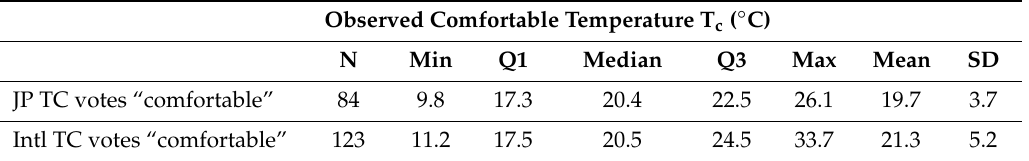
Table 10. Descriptive statistics of the actual temperature at TC + 1, + 2 and + 3 (Comfortable side of the scale).